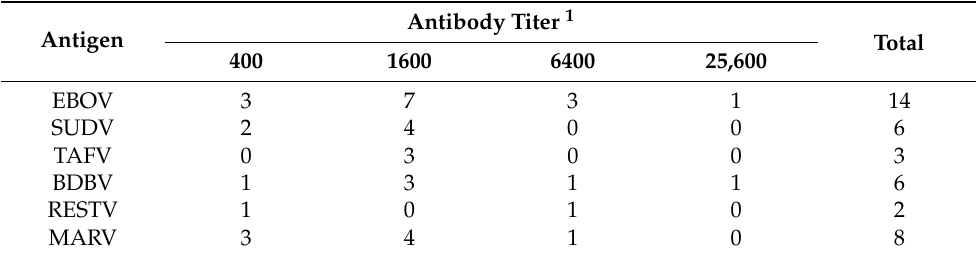
Figure 3. Filovirus species-specificity of IgG antibodies detected in the sera collected from NHPs in Zambia. IgG reactivities to EBOV, SUDV, TAFV, BDBV, RESTV, and MARV GPs are shown as OD values at 450 nm (OD450) in ELISA for the 39 positive samples shown in Table 1. Table 2. Distribution of antibody titers of the IgG positive